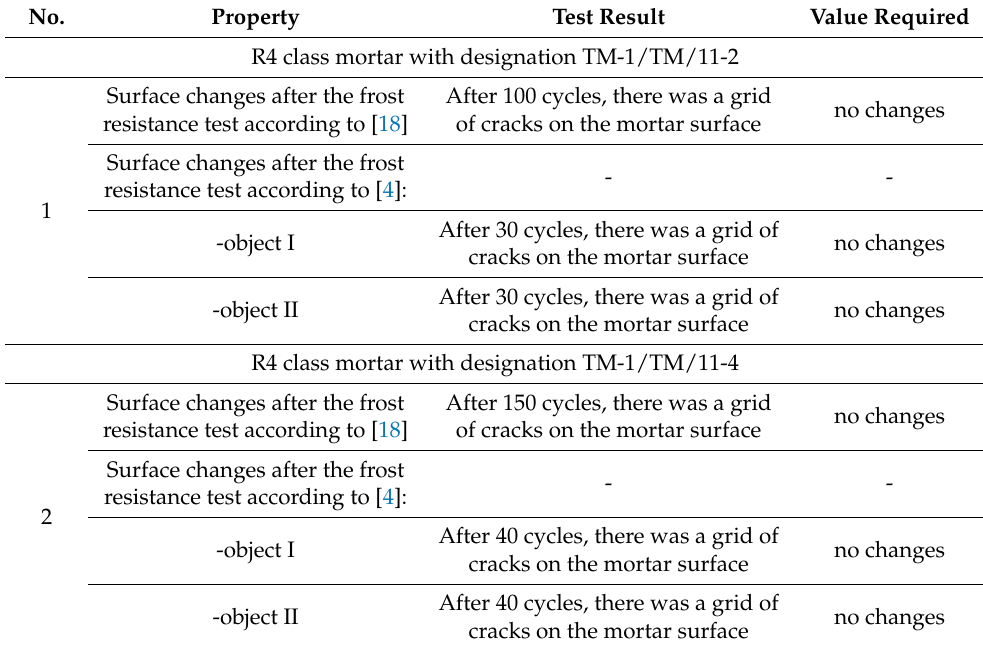
Figure 7. Summary of average values of adhesion by pull-off method for R4 class mortars to concrete substrate after frost resistance test, according to [4], wo ms [MPa]. Table 3. Summary of results of surface changes in R4 class mortars after frost resistance testing, according to [4,16].